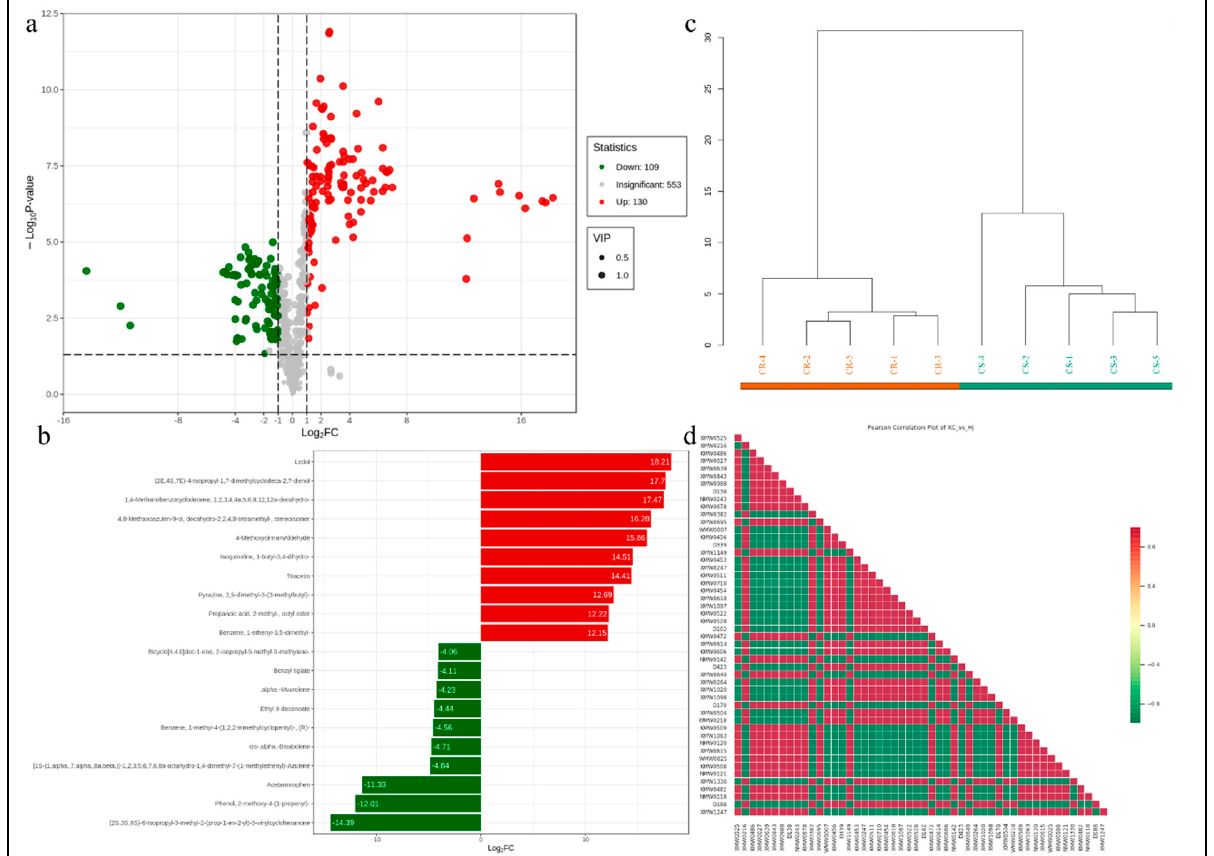
Figure 3. ( a ) Differential metabolite volcano plot. The green and red dots represent the metabolites that were down- and up-accumulated, respectively, in CR as compared to CS. ( b ) Divergence multiple bar chart showing top 10 highly accumulated metabolites in CR ( C. reticulata ; red bars) and CS ( C. x sinensis ; green bars). The x -axis shows the log2 fold change of the differential metabolites and the y -axis shows the metabolite names. ( c ) Dendrogram showing grouping of the CS and CR replicates. ( d ) Pearson Correlation between highly accumulated metabolites in CS and CR.